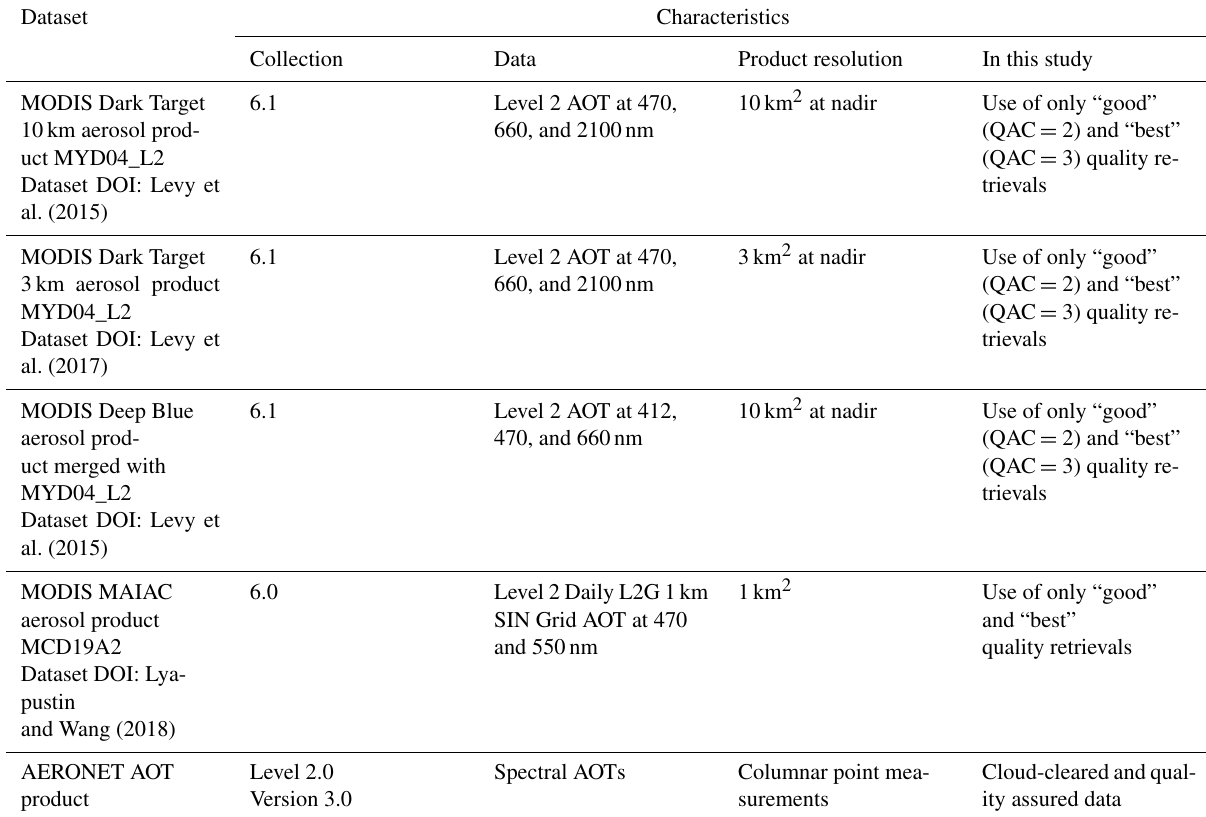
Table 1. MODIS–AERONET aerosol datasets and their characteristics.